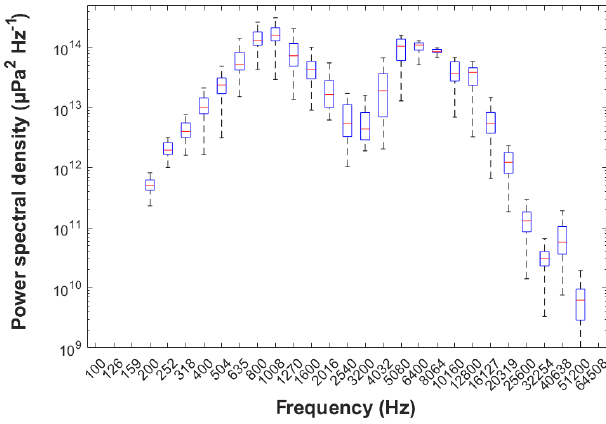
Figure 2. Power spectral densities (µPa 2 Hz − 1 ) of the logarithmic chirps emitted by the